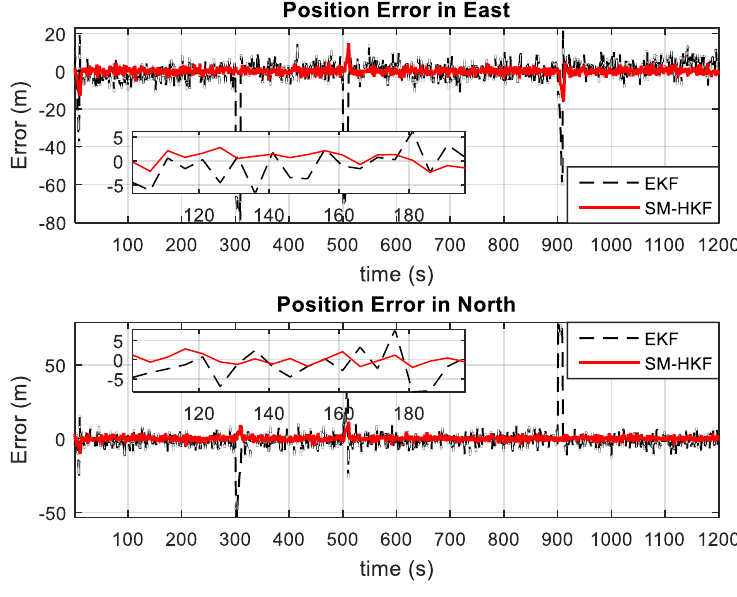
Sensors 2020 , 20 , 627